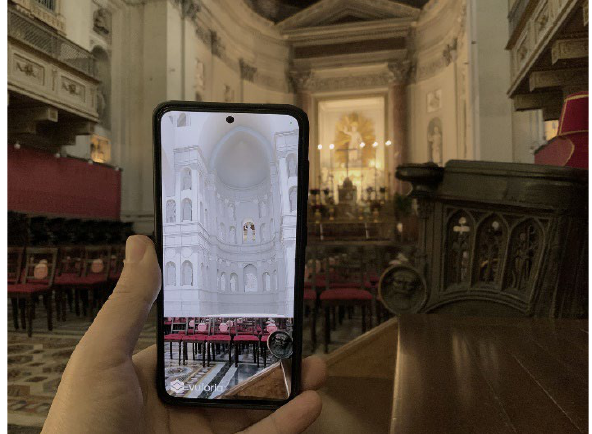
Figure 12. AR Visualization of the Tribuna from the nave of the Cathedral with Vuforia’s Area Target tool.